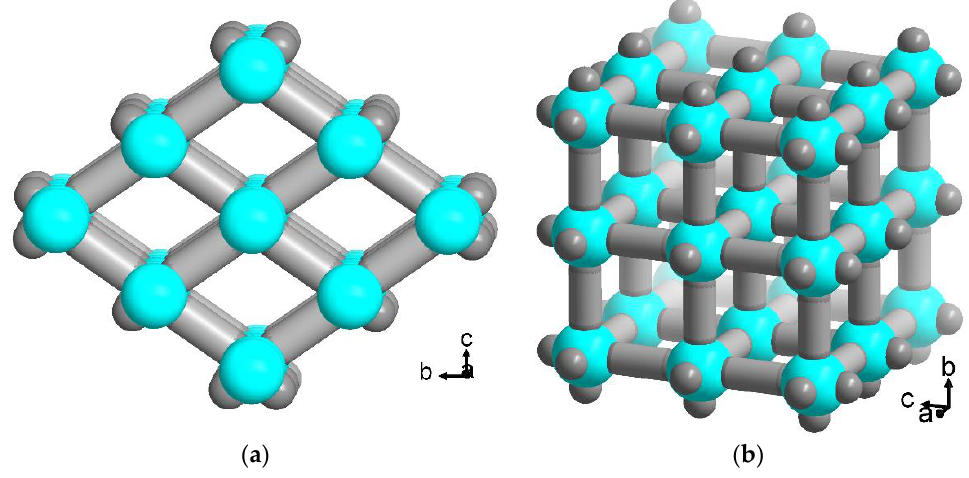
Figure 2. Schematic presentation of the periodic channel structures in ( a ) MIL-53, [Al(OH)(bdc)] and ( b ) MOF-5, [Zn 4 O(bdc) 3 ] (bdc = benzene-1,4-dicarboxylate) (The inorganic building units {AlO 6 } and {Zn 4 (O)(O 2 ) 6 }, respectively, are represented in cyan and the bdc linker schematically as a grey rod; see Section S3, Supplementary materials for structure details). (Structure images were drawn with Diamond [57] from the deposited cif files under CCDC-no./Refcode 220476/SABVUN [41] and 256966/SAHYOQ [52,58].)